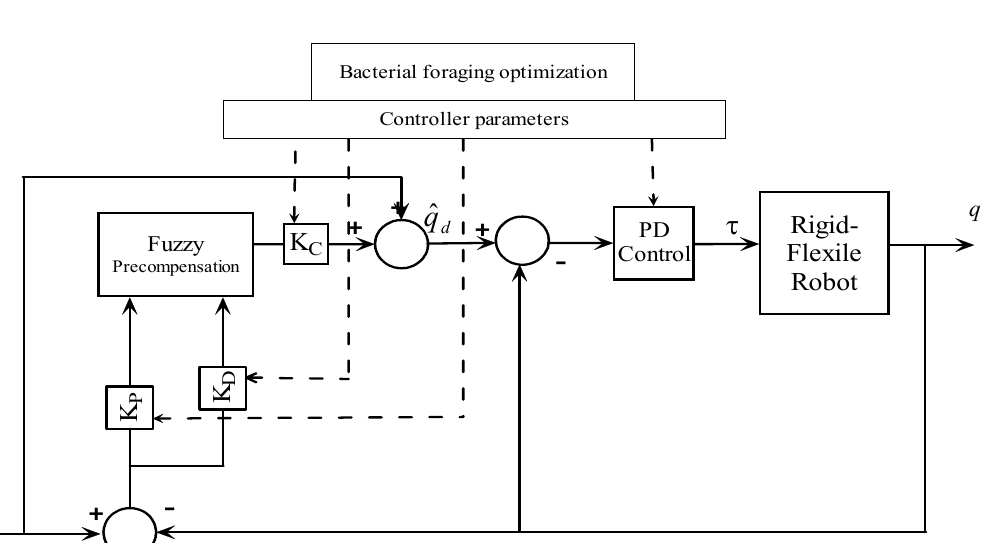
Fig. 6. Bacterial Foraging optimized Fuzzy Precompensated PD Control